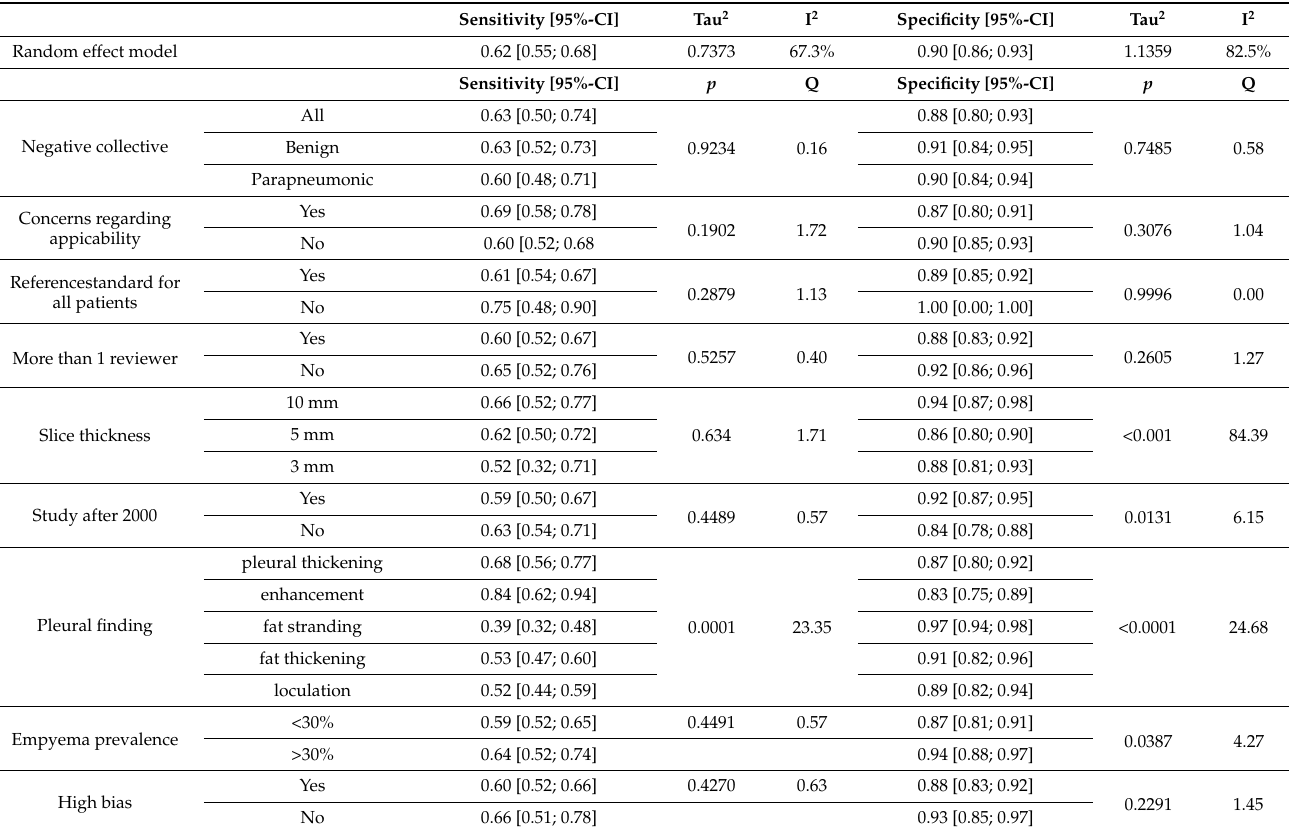
Table A6. Subgroup